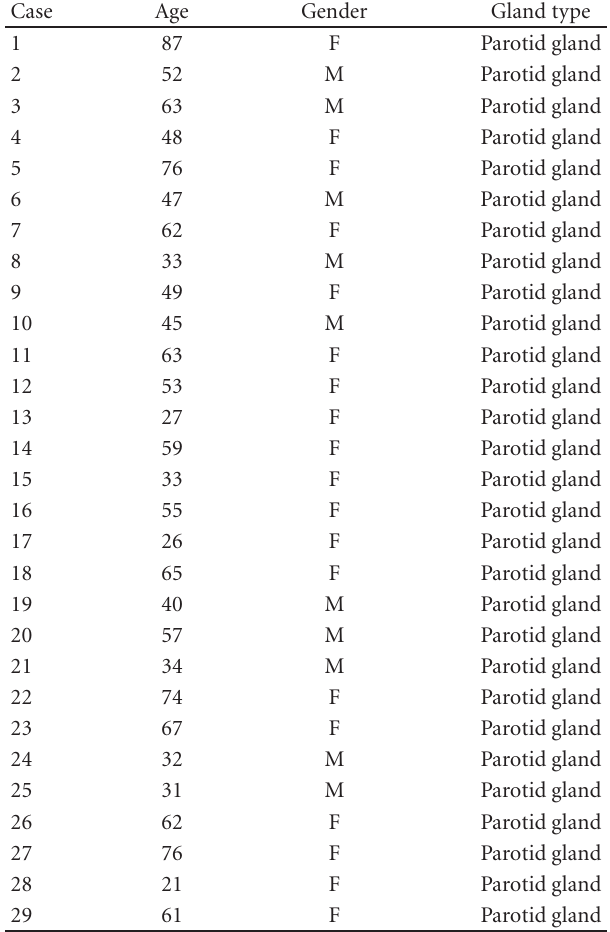
Table 1: Clinical data of pleomorphic adenomas